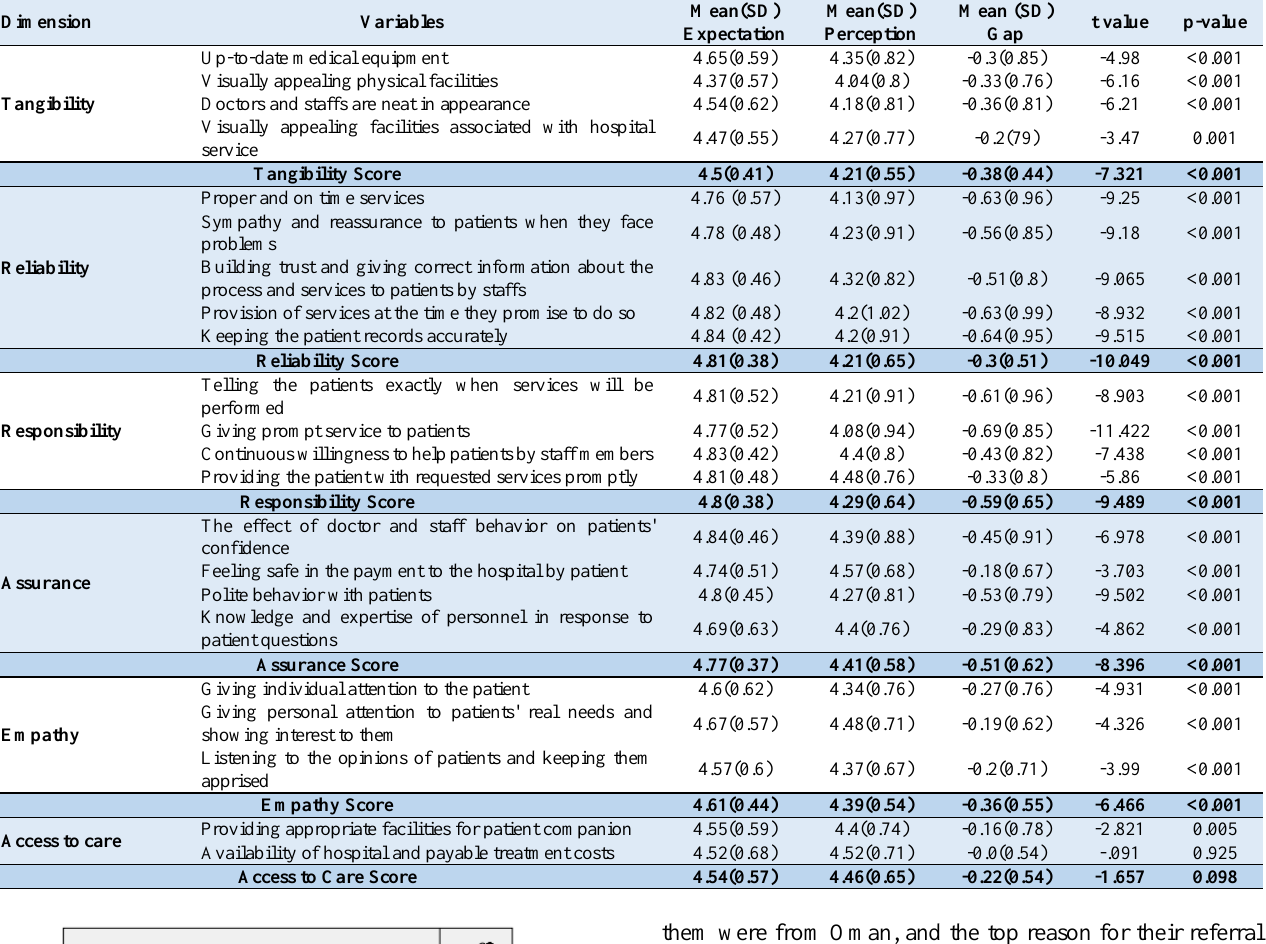
p-value t value